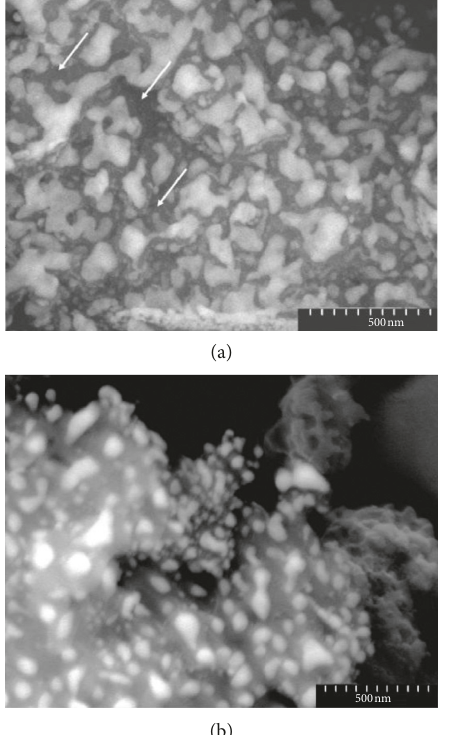
Figure 6: FESEM micrograph of the synthesized powders: (a) n � 1 and (b) n �